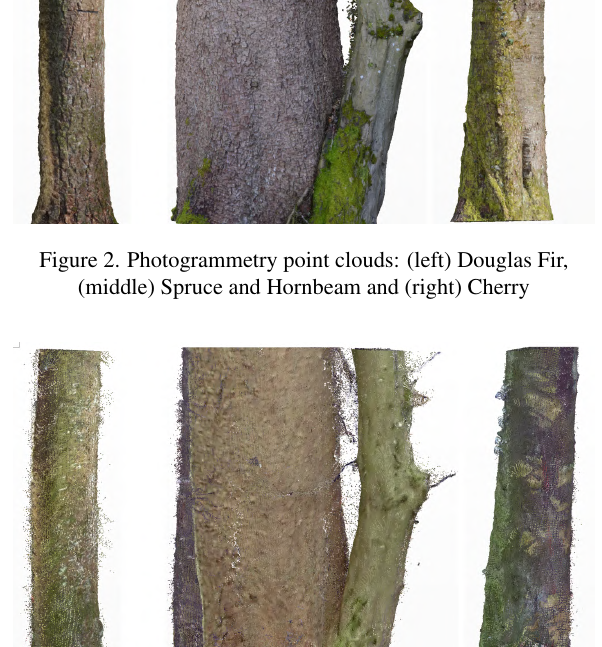
Table 3. Statistical values of the DBH residuals.